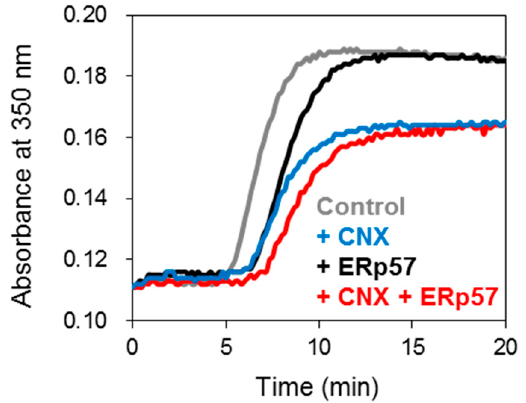
Figure 4. The ERp57-CNX complex inhibits client aggregation. Chaperone activity was assessed by monitoring the absorbance at 350 nm using 0.5 µ M luciferase with or without ERp57 and/or CNX. The aggregation kinetics of luciferase with no chaperone, CNX, ERp57 and CNX-ERp57 are shown in grey, blue, black and red lines, respectively. Experiments were independently repeated three times with reproducible results.